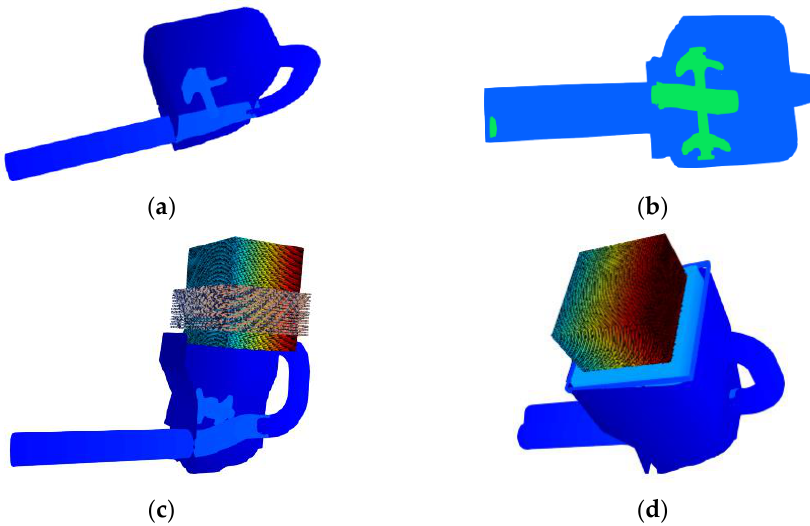
Figure 16. Simulation analysis model of concrete pumping. ( a ) Y – Y Cross-sectional view. ( b ) Complete machine. ( c ) SPH-DEM particles. ( d ) Whole model of concrete pumping.